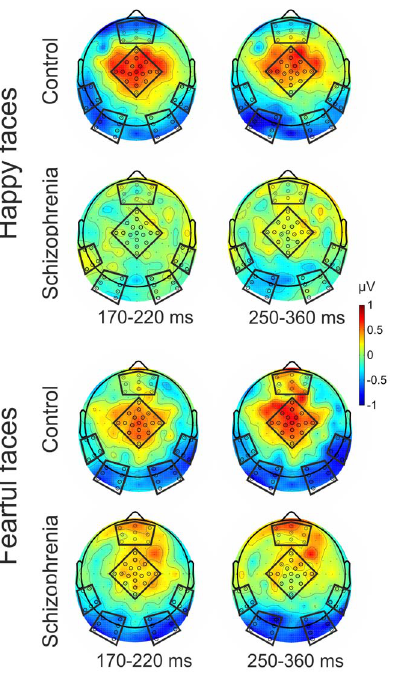
Figure 3. Scalp topography of the mismatch responses. Electrode clusters selected for analyses are marked with black dots in black frames (Region of Interests: ROIs).